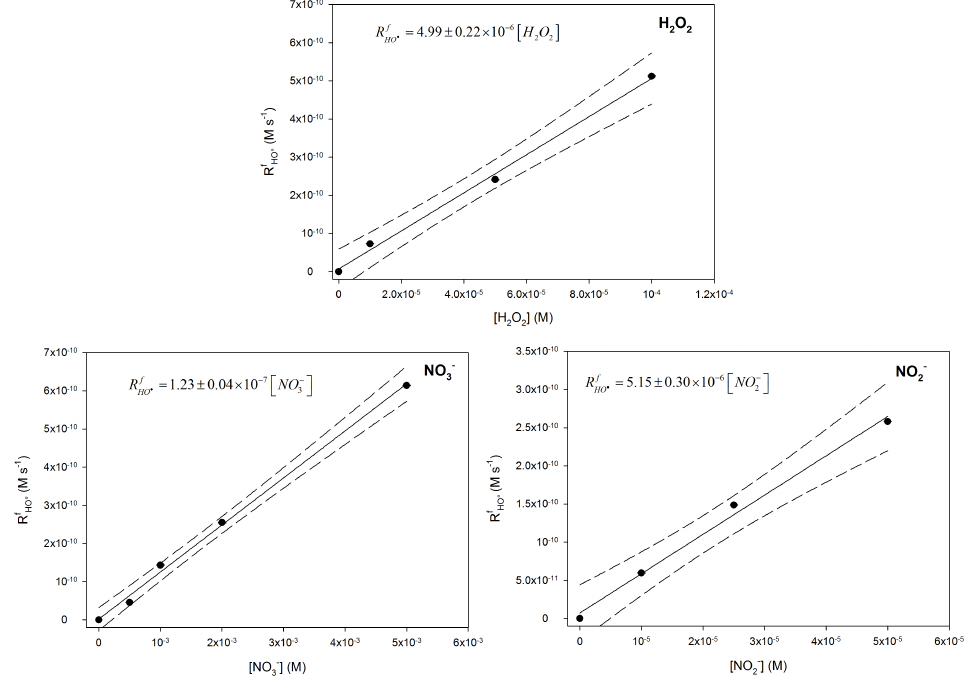
Figure 3. Scatter plots of hydroxyl radical formation rates vs. hydrogen peroxide, nitrate and nitrite concentrations using 2mm of TA at pH 5.0 under xenon lamp irradiation. The solid line is the linear fit and dashed lines denote the 90% confidence of the linear fit. (cid:113) (Ms − 1 ) and hydroxyl radical polychromatic quantum yield formation ( (cid:56) Table 2. R f HO samples. NM: not measured. Mar: Marine. H-Mar: Highly Marine. Cont: Continental influence. The errors on R f level simply from the scattering of experimental